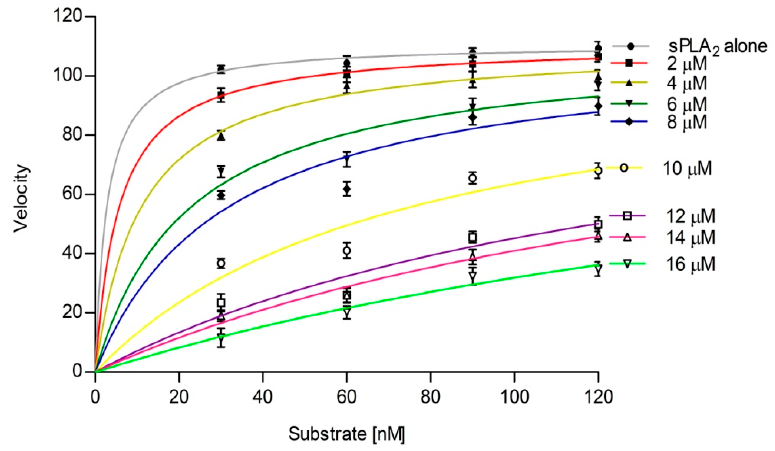
Figure 6. Inhibition constant (Ki) of sinapic acid for sPLA2-IIA. The primary data fit the competitive inhibition model, and Ki was determined byincreasing the concentrations of sinapic acid by using Graph pad prism 5.0. Values plotted mean ± standard deviation (n = 3).